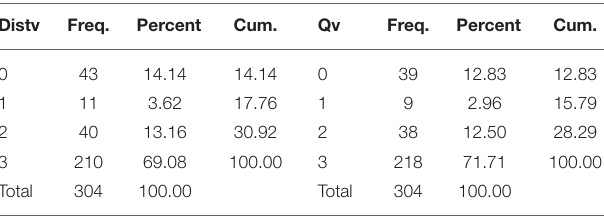
TABLE 5 | Distribution of dependent variables on the WTP for distance and quality parameters. Distv Freq.